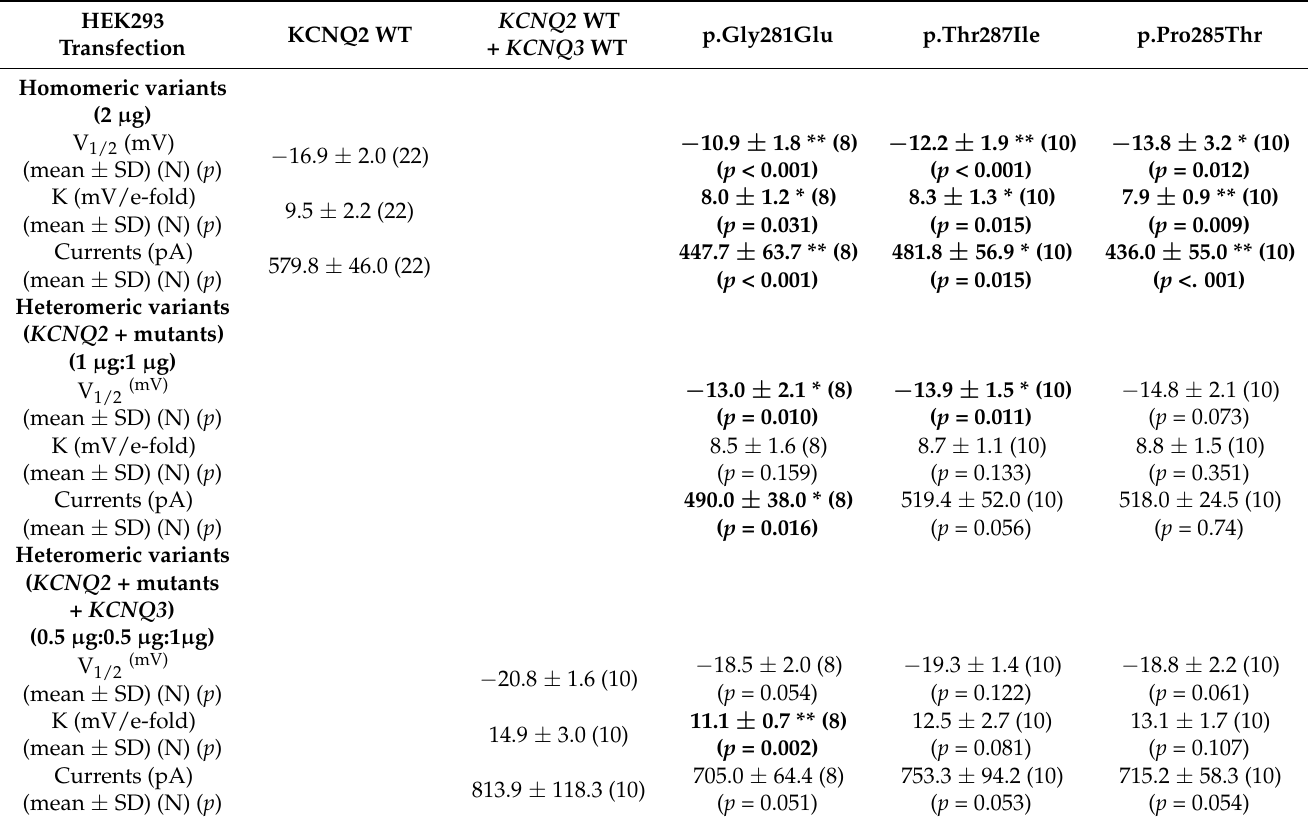
Table 2. Electrophysiological study in three KCNQ2 mutations in SF